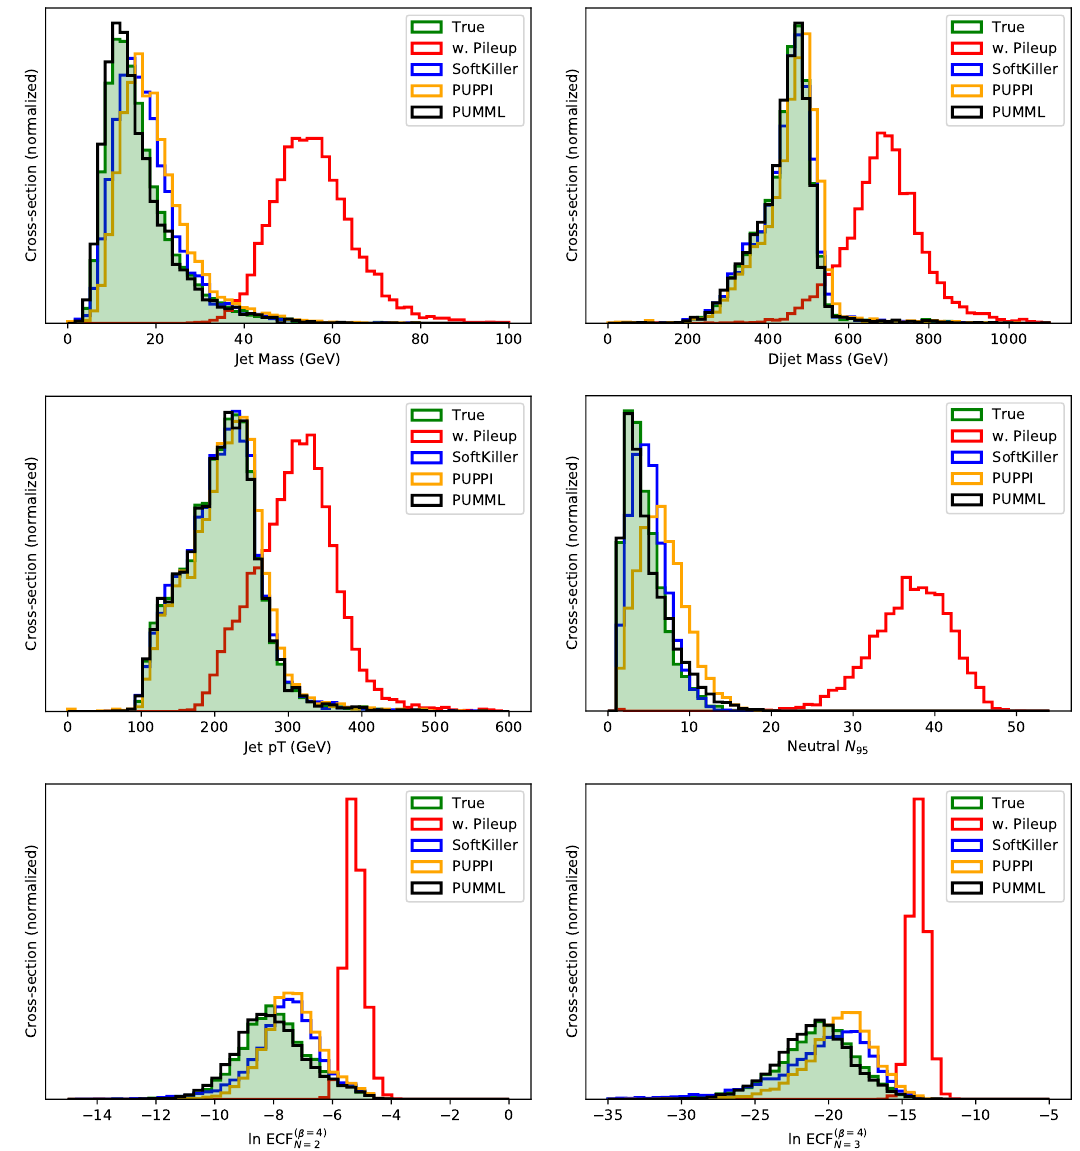
Figure 4 . Distributions of leading jet mass (top left), dijet mass (top right), leading jet p T (middle left), neutral N 95 (middle right), ln ECF ( (cid:12) =4) (bottom left), and ln ECF ( (cid:12) =4) (bottom right) for N =2 N =3 the considered pileup subtraction methods with Poissonian h NPU i = 140 pileup. While all of the pileup mitigation methods do well for observables such as the dijet mass and jet p T , PUMML more closely matches the true distributions of more sensitive substructure observables like mass, neutral N 95 , and the energy correlation